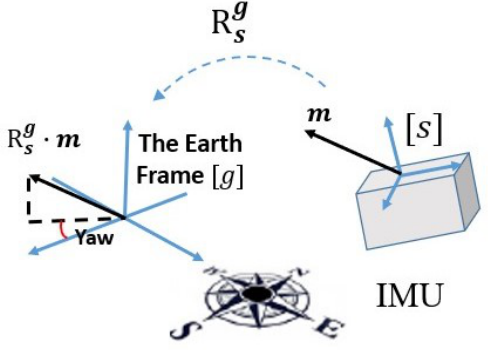
Figure 2. The schematic figure of drfit correction, where R g s denotes the rotaion matrix from the sensor-fixed frame [ s ] to the Earth frame [ g ]